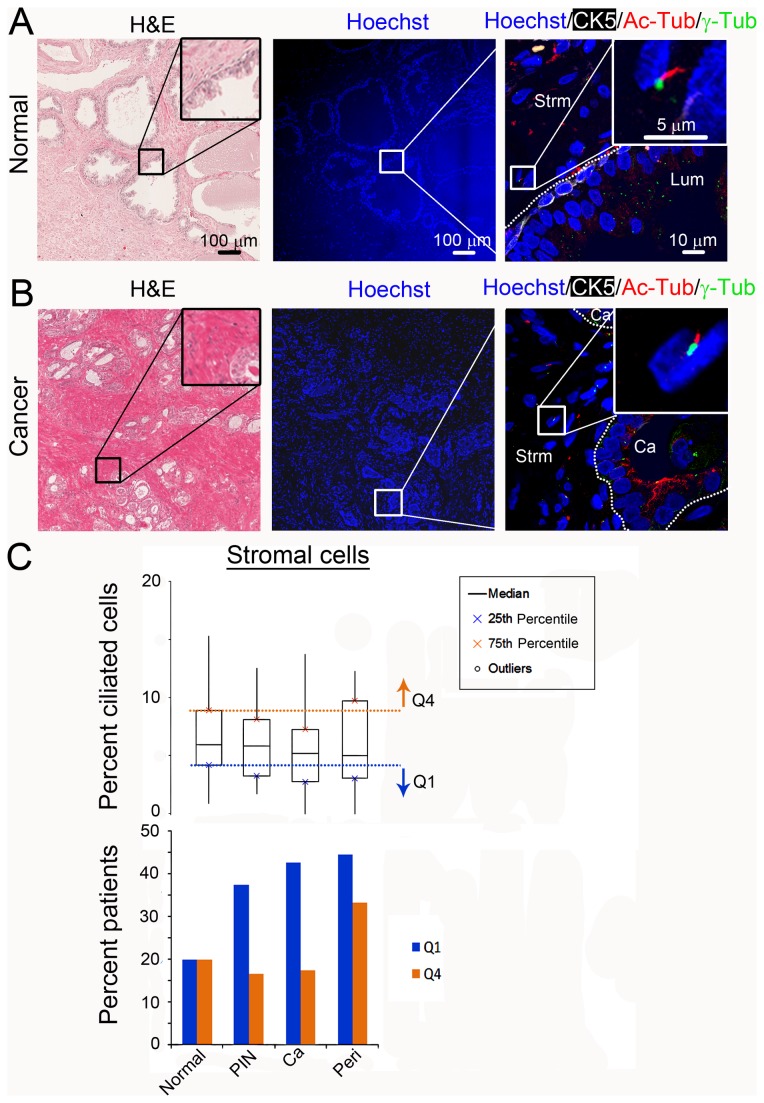
Frequency of cilia does not change on stromal cells surrounding cancer.Images of (A) normal prostate and (B) prostate cancer show nuclei (Hoechst; blue), cytokeratin 5 (CK5; white), primary cilia (Ac-Tub; red) and centrosomes (γ-Tub; green). Inset shows magnification of primary cilia on stromal cells associated with (A) normal tissue and (B) cancerous tissue (C, top). Boxplot describe the percent ciliated stromal cells per patient for each tissue type: normal, prostatic intraepithelial neoplasia (PIN), cancer (Ca), and perineural invasion (Peri). Q4, Q1 are as in Figure 1 (C, bottom). The percent of patients with an abnormally high percent cilia (Q4; orange) or an abnormally low percent cilia (Q1; blue).